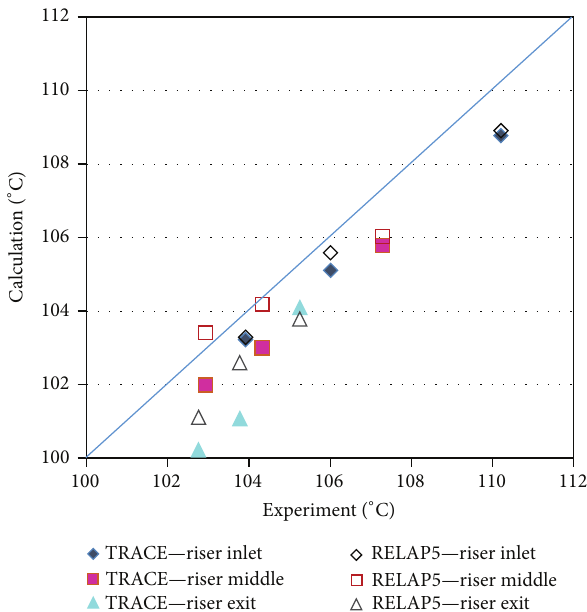
Figure 9: Test I-2: water temperature in the riser. Maximum, average, and minimum values are provided for each